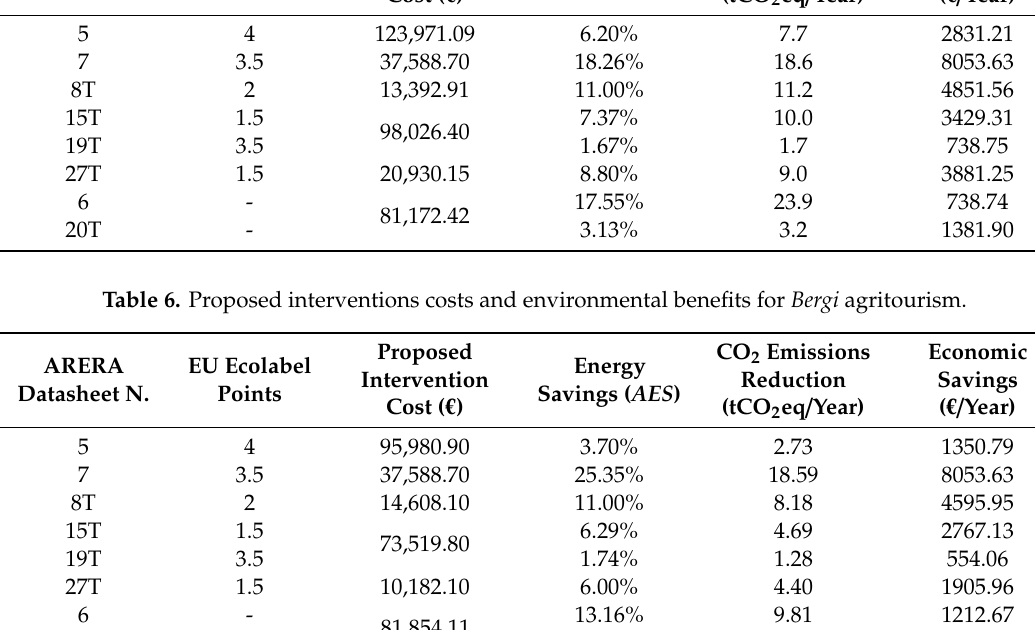
Table 5. Proposed interventions costs and environmental benefits for Villa Dafne agritourism. Proposed ARERA EU Ecolabel Datasheet N. Points